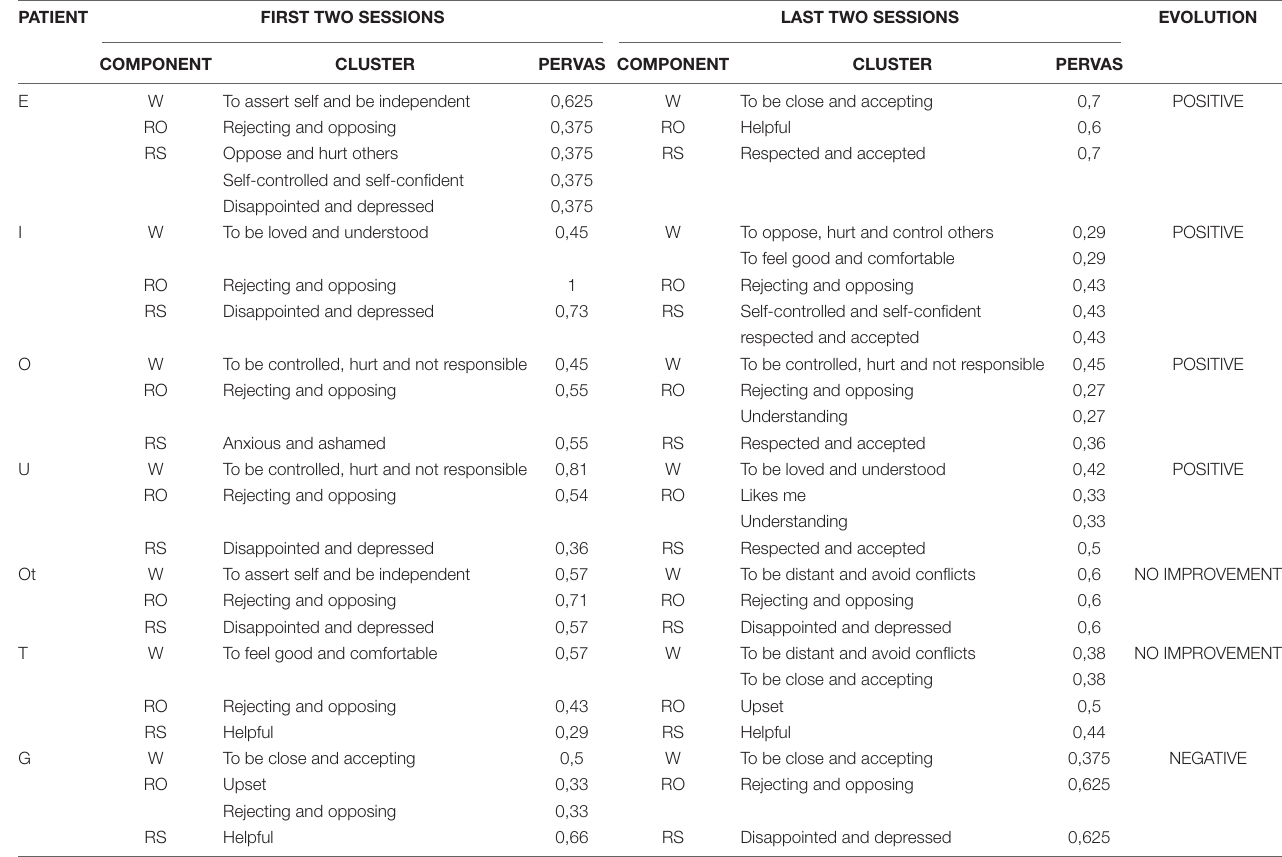
TABLE 3 | CCRT’s data.